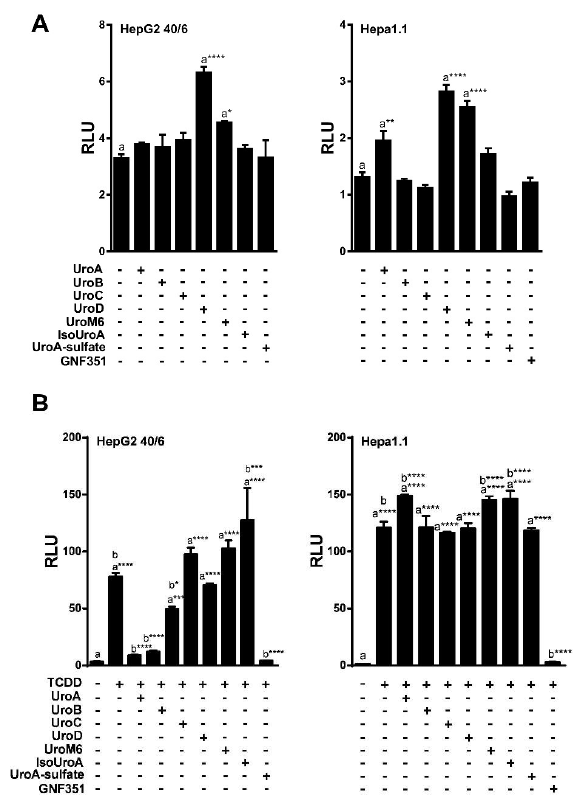
Figure 2. UroA, B and C attenuate TCDD-induced luciferase activity. ( A ) Agonist capacity of urolithin metabolites (10 µ M) in human HepG2 (40/6) and mouse Hepa1.1 cell lines. DRE-driven reporter cell lines treated for 4 h with compounds as indicated; ( B ) Antagonist potential of urolithins in reporter cells. HepG2 (40/6) and mouse Hepa1.1 cells were co-treated with TCDD and urolithins (10 µ M) for 4 h, lysed, and luciferase activity was measured. Data are presented as mean +/ − S.E.M., n = 3; significance was determined by one-way ANOVA, p -value ≤ 0.01 (**), p -value ≤ 0.001 (***) or p -value ≤ 0.0001